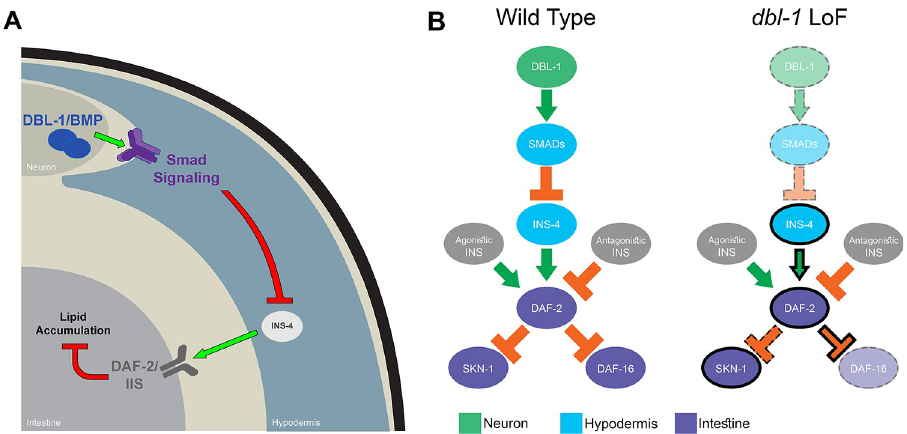
Fig 5. Model for interaction between DBL-1/BMP signaling and DAF-2/InsR pathways. A) Smad signaling in the hypodermis regulates the transcription of ins-4 , which in turn feeds into DAF-2/IIS in the intestine to control lipid metabolsim. B) In wild-type animals, DAF-2/InsR is regulated by multiple agonistic and antagonistic ILPs. DAF-2/ InsR activation leads to phosphorylation and cytoplasmic retention of SKN-1/Nrf and DAF-16/FoxO. In dbl-1 loss-of- function (LoF) mutants, reduced Smad activity leads to increased INS-4 expression. Also in dbl-1 mutants, SKN-1/Nrf nuclear localization has reduced sensitivity to DAF-2/InsR activity, while DAF-16/FoxO nuclear localization has increased sensitivity to DAF-2/InsR